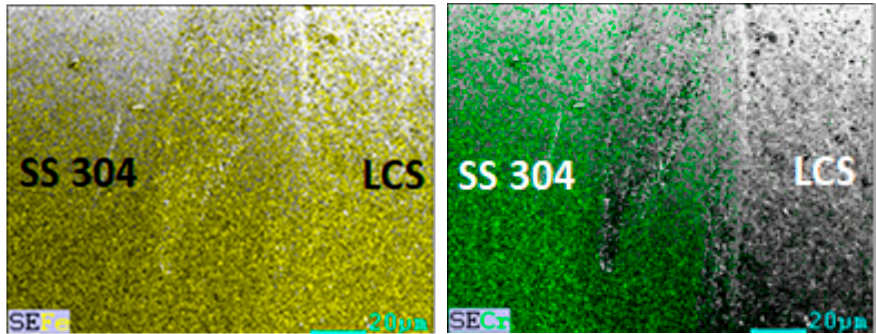
Figure 6. Microstructure of the interface at the joint of low-carbon steel–304 SS ( a ) and medium- Figure 7. EDS element (Fe and Cr) mapping at the joint of low-carbon steel–304 SS. carbon steel–304 SS ( b ).